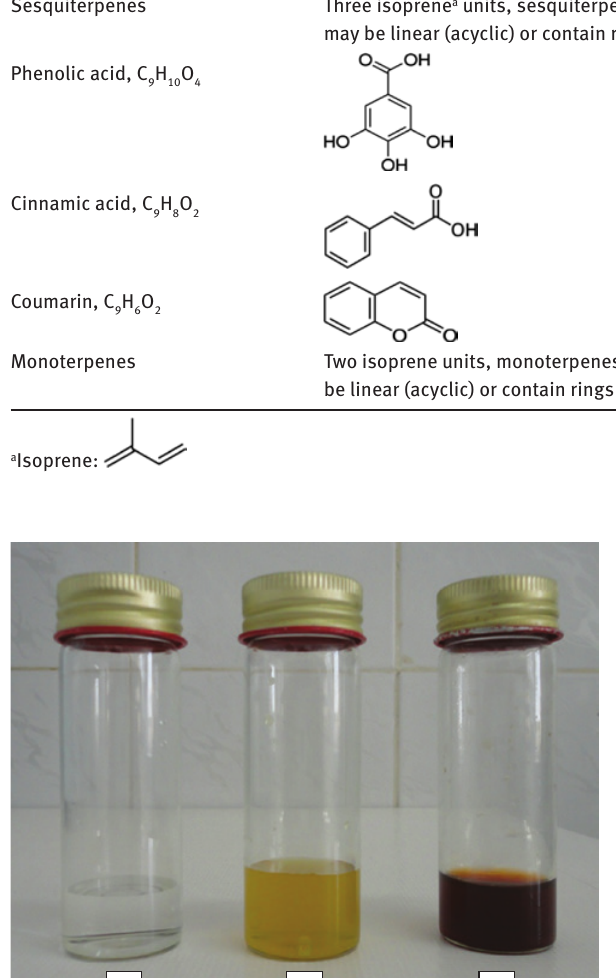
Figure 2: Color and appearance of the AgNO gonium/Geranium leaf extract (B), and synthesized AgNPs using Pelargonium/Geranium leaf extract